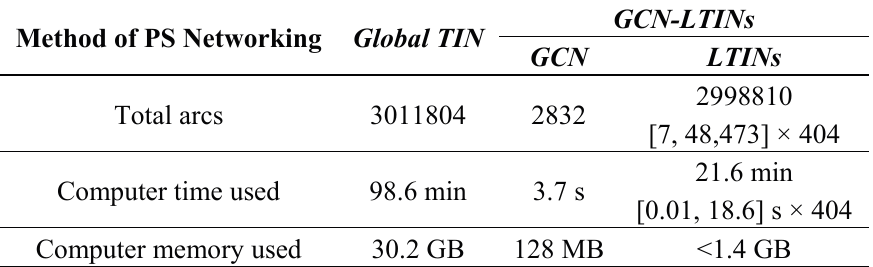
Table 1. Comparison of computing time and memory required for the two types of solutions based on the global control network plus localized triangular irregular networks and the global triangular irregular network,